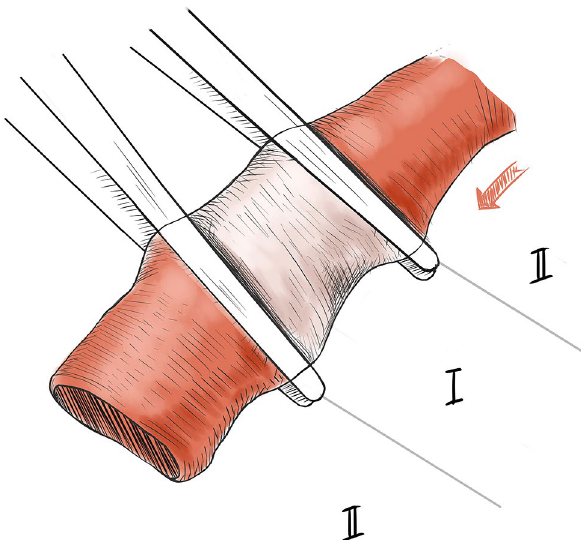
Figure 4. Schematic Diagram of Successful Blood Blocking. After the blood vessel was clamped proximally, microscopic tweezers were used to compress it and drain the blood out in a distal direction starting from the clamp. Failure of the evacuated part of the blood vessel to refill or leak was taken to indicate that blood flow had been blocked. (Adobe Photoshop: 21.0.1 20,191,106.r.47 2019/11/06:3152b481f18 × 64 https ://www.adobe .com/ cn/produ cts/photo